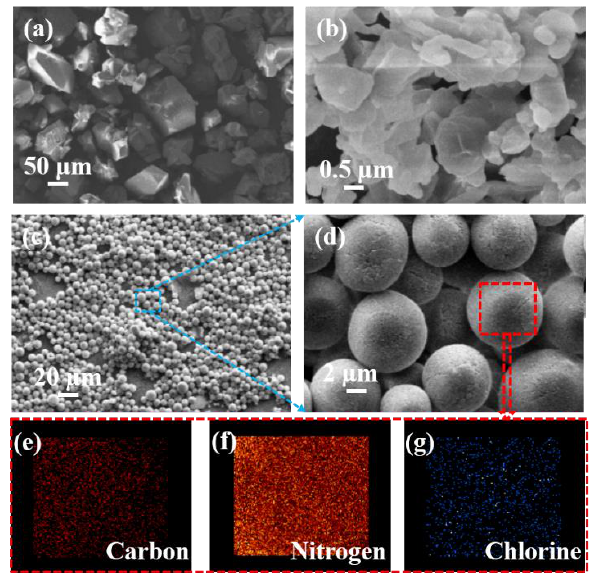
Figure 2. SEM micrographs of ( a ) raw CL-20 crystal, ( b ) raw PNCB crystal, ( c ) and ( d ) micro-sized spherical CL-20/PNCB composite, and ( e – g ) the EDX maps of carbon distribution, nitrogen distribution and chlorine distribution, respectively.